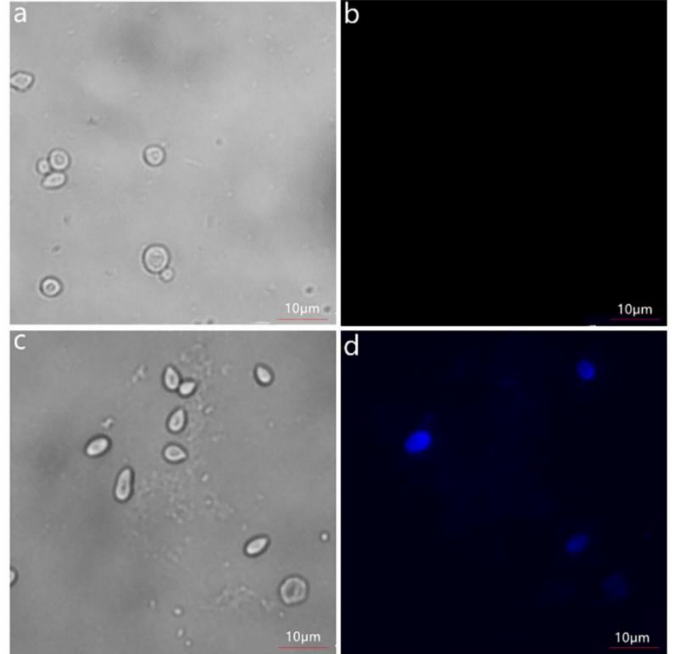
Figure 3. Immunofluorescence labeling of recombinant enzyme displayed on the yeast cell surface. ( a , b ) the bright-field and immunofluorescence micrographs of S. cerevisiae EBY100 cells harboring pESC-leu, respectively; ( c , d ) the bright-field and immunofluorescence micrographs of S. cerevisiae EBY100 cells harboring pESC-leu- levU - FLO1,